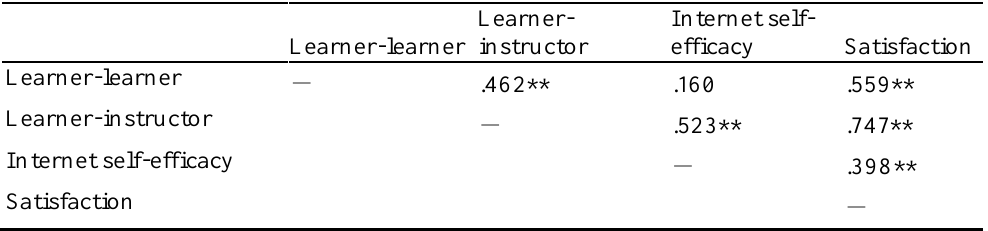
Correlations Among Independent Variables and Student Satisfaction Learner- Internet self- Learner-learner instructor efficacy Satisfaction Learner-learner － .462**